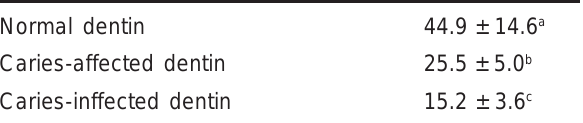
TABLE 1 - Tensile bond strength of ABF (Protect Bond) in normal, caries-affected and caries-infected dentin